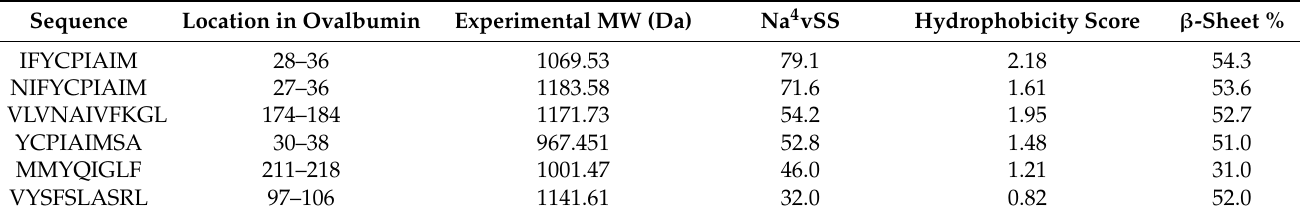
Table 1. Physicochemical properties and aggregation propensity of the ovalbumin-derived